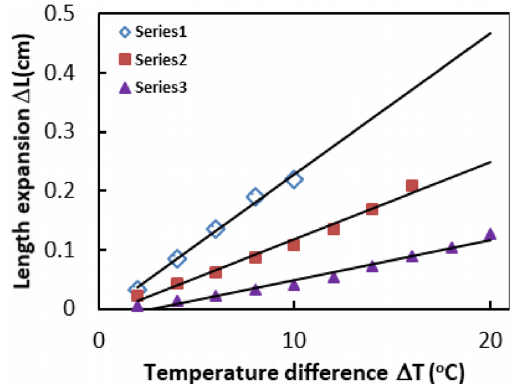
Figure 8. Third experiment design: the effect of alcohol concentration towards linear thermal expansion. Series 1, 2, and 3 relate to alcohol concentration 90%, 70%, and 30% (v/v), respectively. The contextual problem is given to find materials suitable for a new